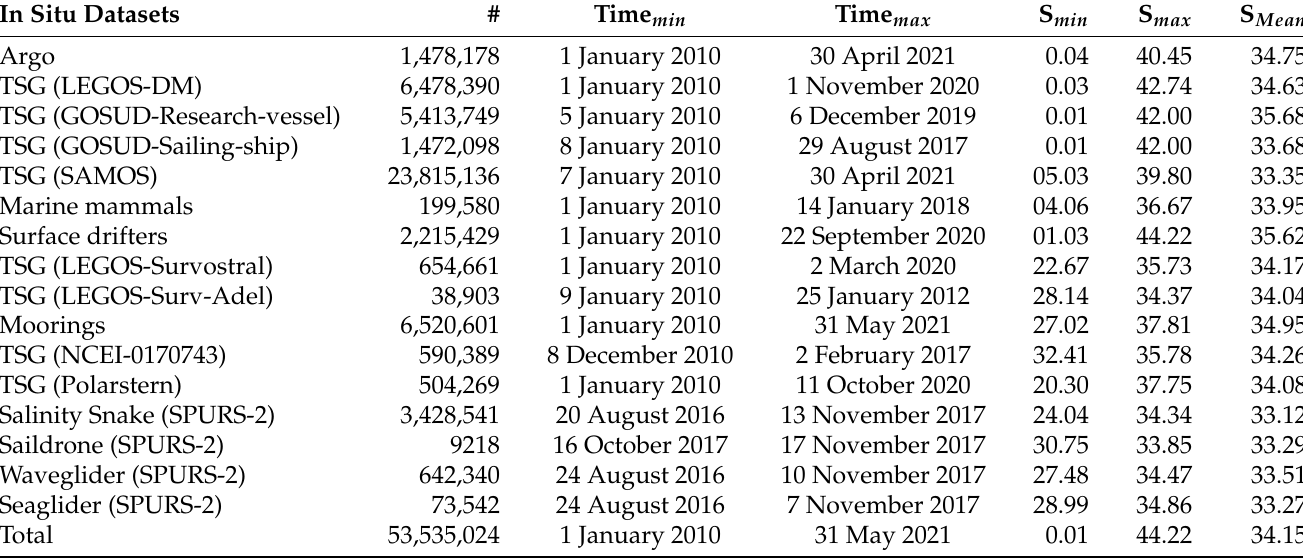
Table 1. Number (#) of in situ SSS observations per type of in situ dataset denoted in the first column. Time interval (Time min Time max ) of first and last observations and minimum (S min ), maximum (S max ) and mean (S mean ) salinity values, as collected and used in the match-ups and reports released on the 15 June 2021, are shown. DM stands for delayed